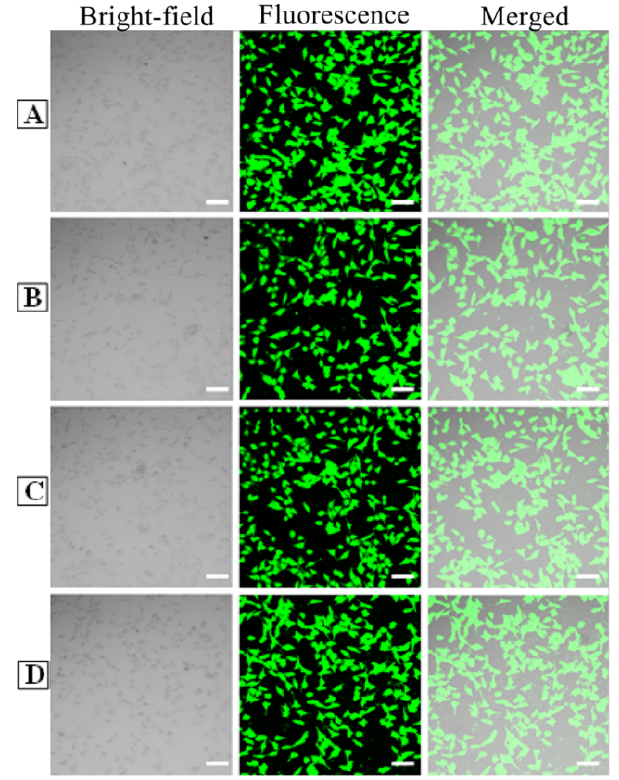
Figure 21. Confocal fluorescence images of HeLa cells stained with 24a – d . ( A ) 24a fluorescence, ( B ) 24b fluorescence, ( C ) 24c fluorescence, and ( D ) 24d fluorescence. λ ex = 405 nm. λ em = 460 − 550 nm. Scale bar: 100 μ m. Adapted from [61].